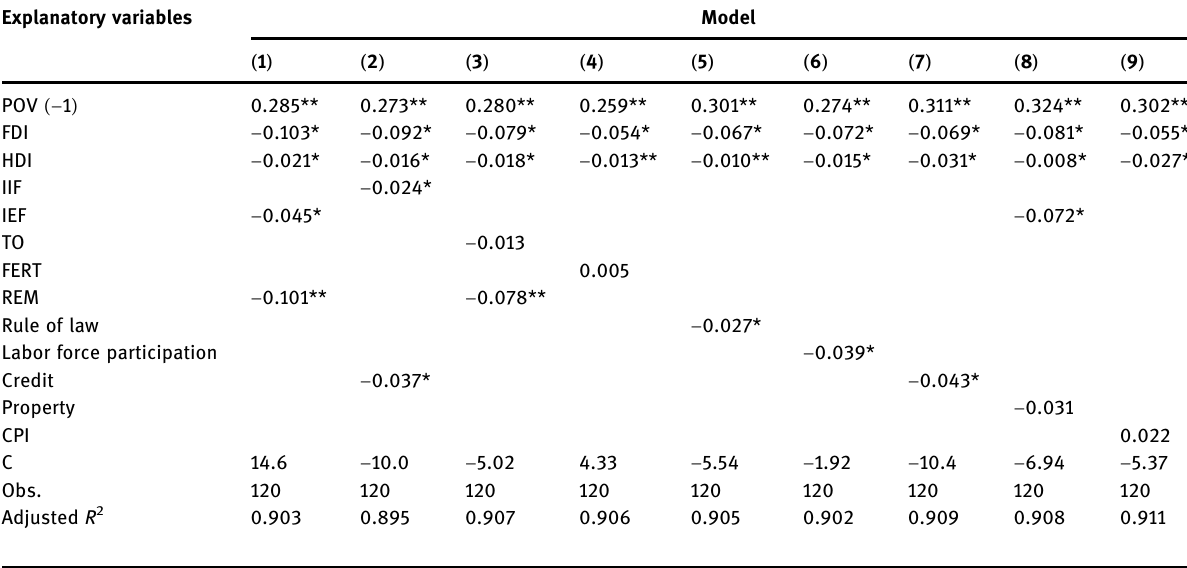
Table A5: Fixed e ff ects regression